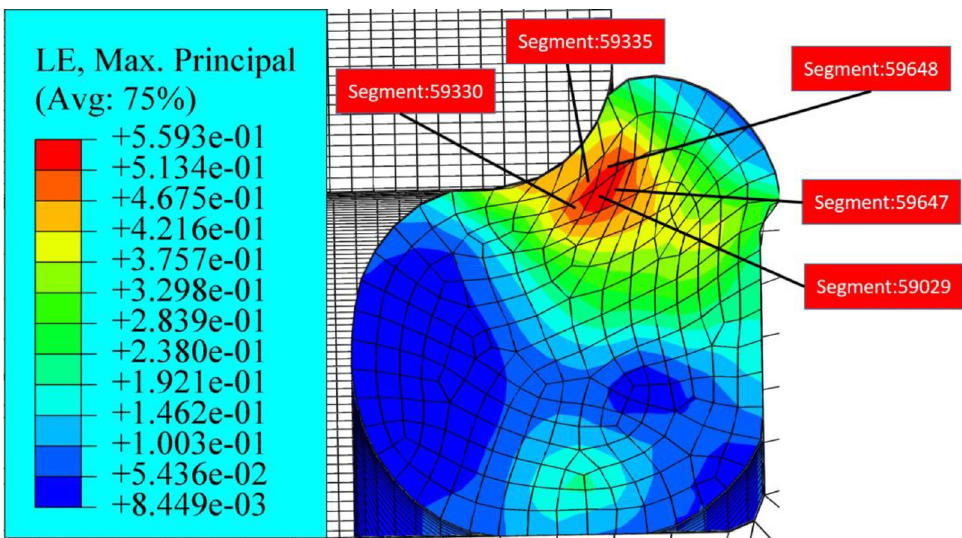
Fig. 5. Distribution of dangerous cross-section segments on the seal ring during shaft-disposable tip assembly.